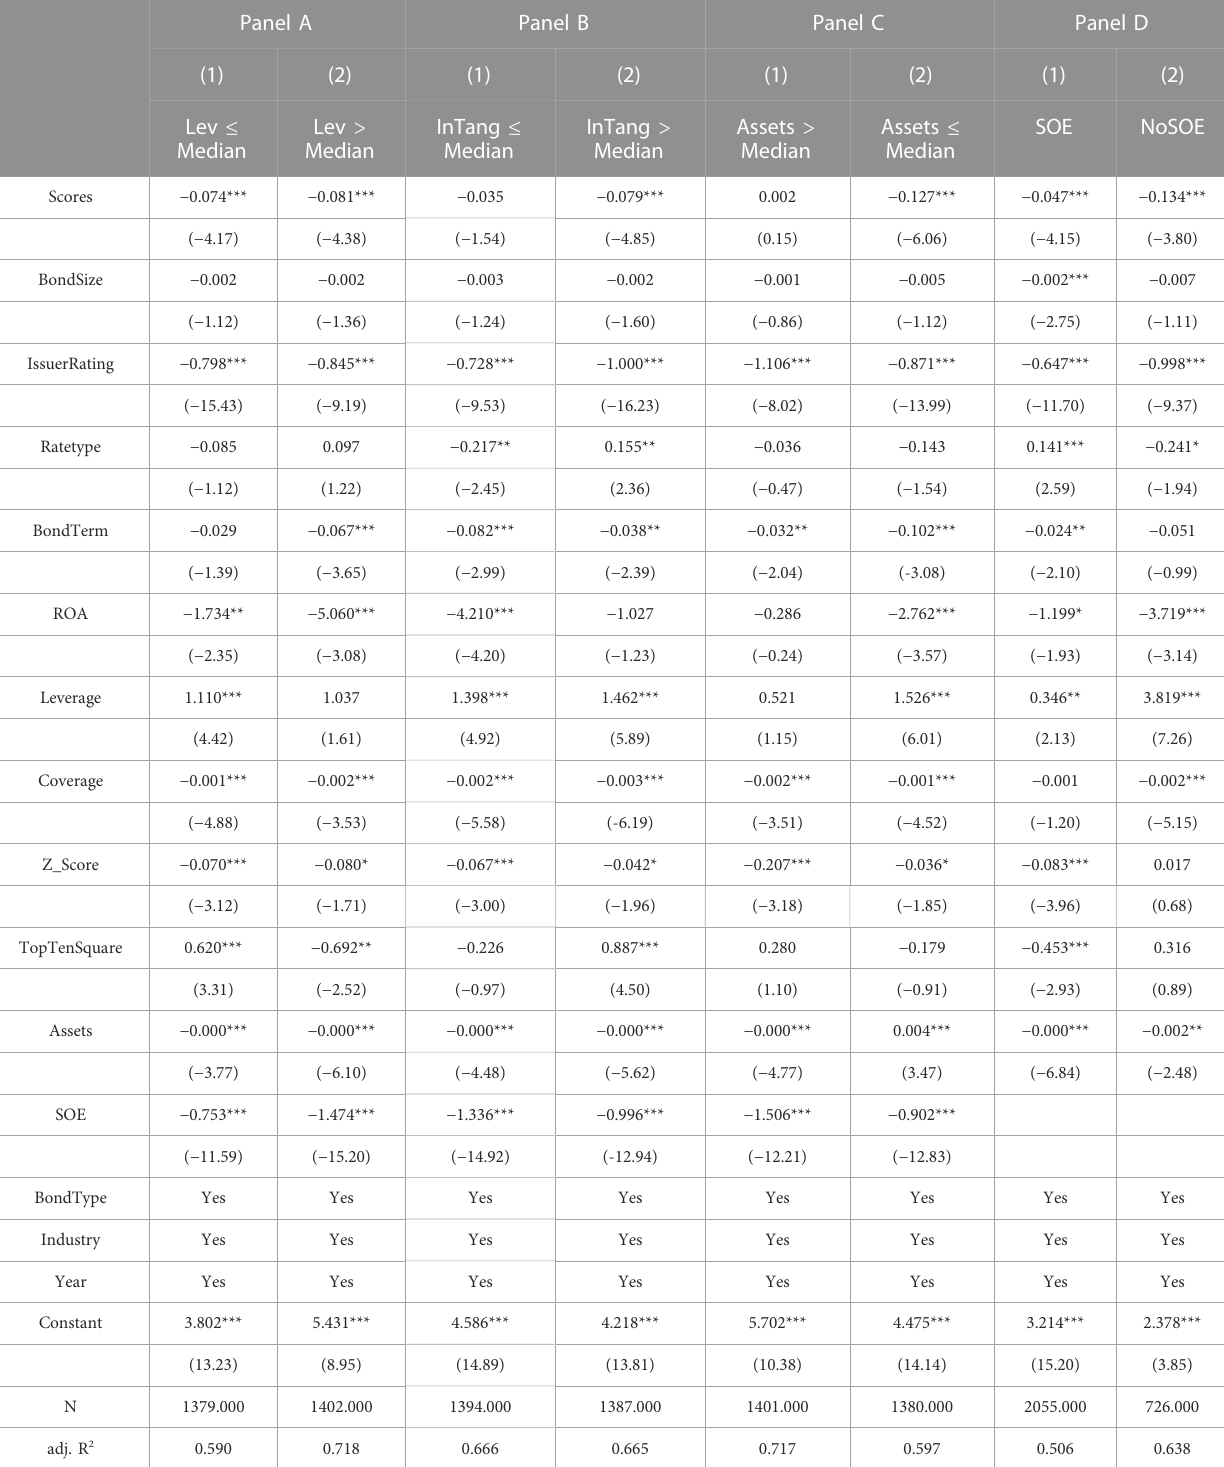
TABLE 7 Debt fi nancing capabilities